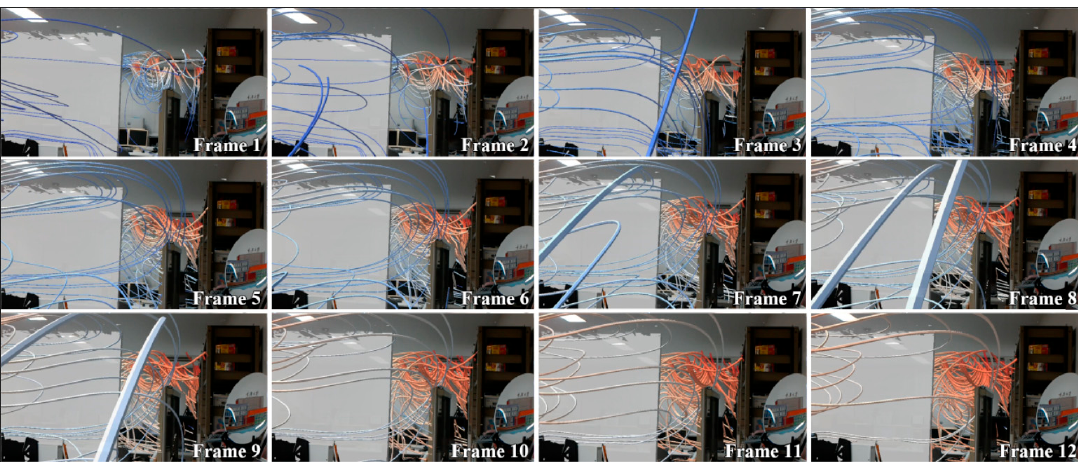
Figure 15. Animated CFD result of case b3 in the HMD.